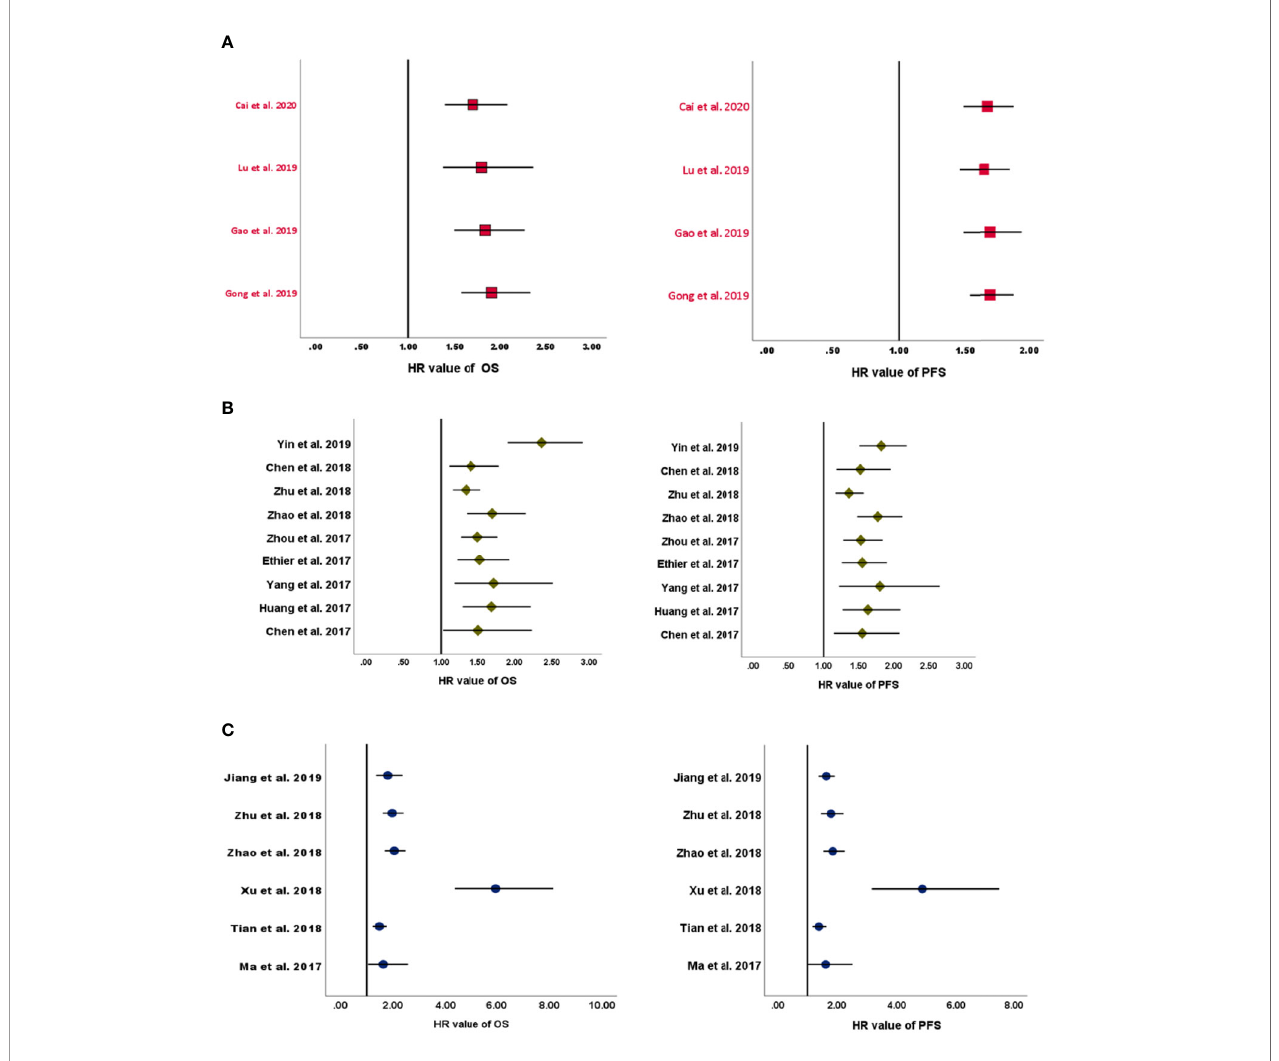
FIGURE 2 | Forest plots of pooled HRs for (A) LMR, (B) NLR, and (C) PLR. HRs, hazard ratios; LMR, lymphocyte-to-monocyte ratio; NLR, neutrophil-to- lymphocyte ratio; PLR, platelet-to-lymphocyte